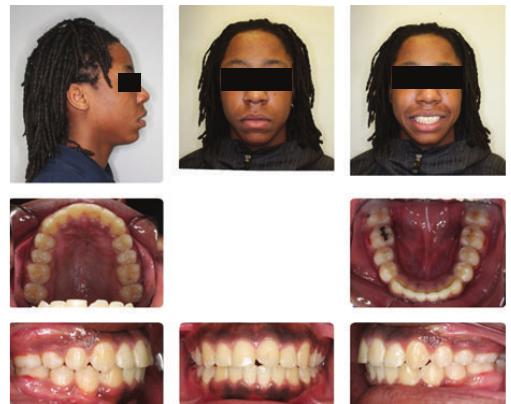
Figure 9: Stage 1: Orthodontic Treatment Final Composite.